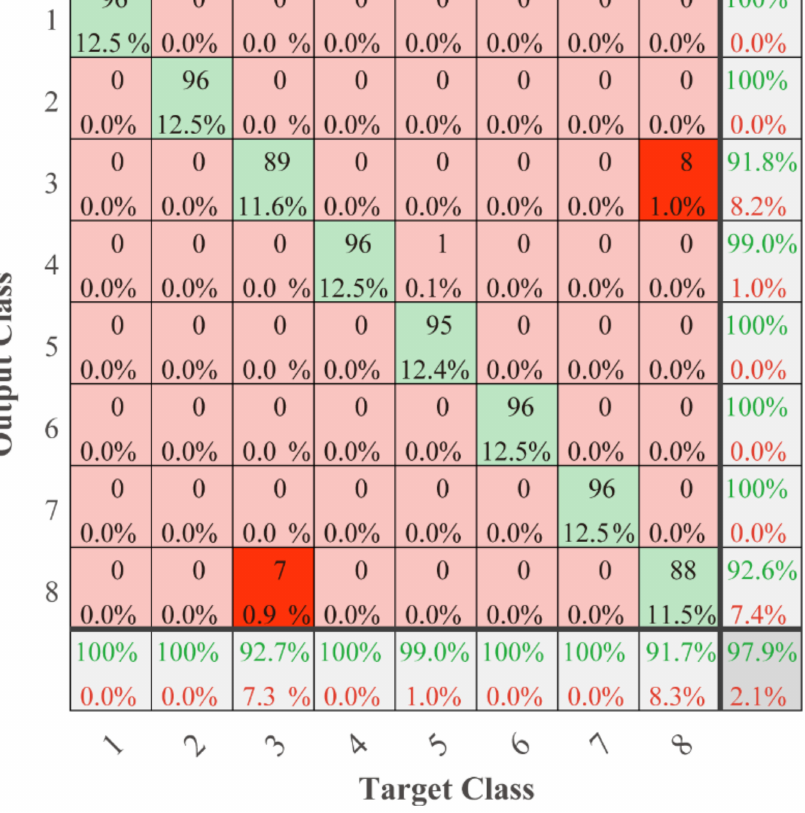
Figure 10. Confusion matrix of all samples.